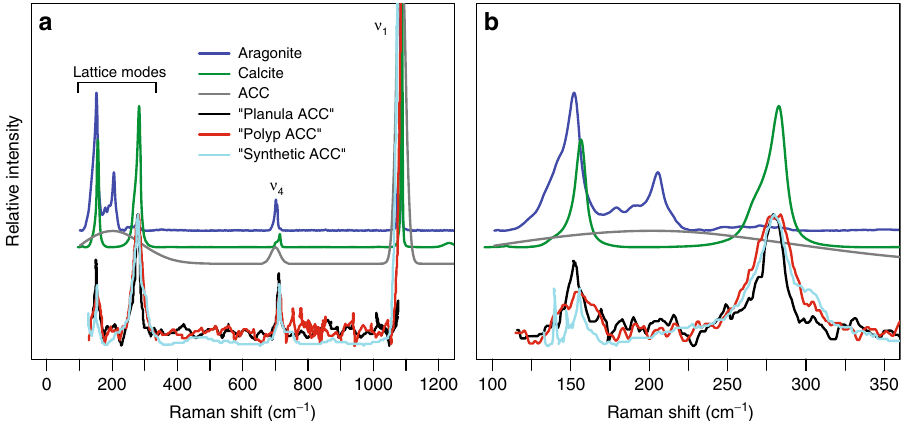
Fig. 1 Reference Raman spectra of calcium carbonates: aragonite (blue), calcite (green), and ACC (gray). a shows the broad spectrum from 0 to 1300 cm − 1 that includes both lattice and internal modes, and b shows the narrower 100 – 400 cm − 1 lattice-mode region. Internal modes ν 1 and ν 4 are labelled, and the region of lattice modes for aragonite and calcite is indicated. The “ Planula ACC ” (black), “ Polyp ACC ” (red), and “ Synthetic ACC ” (cyan) lines show the data from Akiva et al. 1 interpreted as spectra of ACC. These three spectra all have distinct lattice mode peaks, clearly demonstrating they are not ACC, but rather a crystalline calcium carbonate consistent with